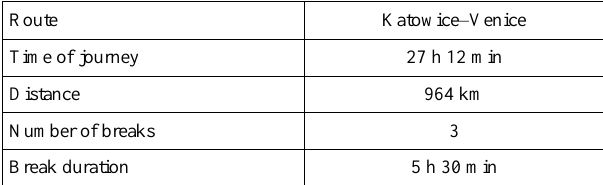
Table 4. Route details generated for Nissan Leaf [7] Route